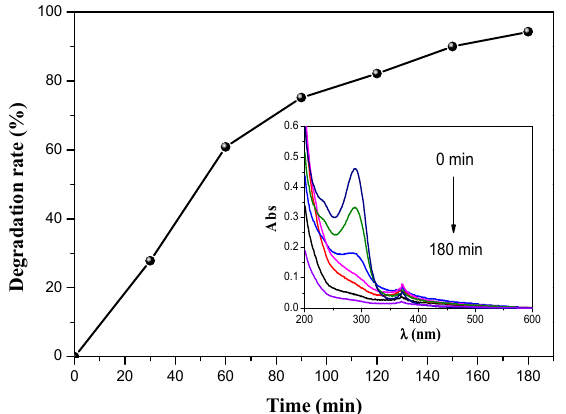
Figure 7. Degradation efficiency on CFX as a function of time; [CFX] 0 = 10 mg/L, catalyst dose 1 g/L; inset: UV–visible spectra.